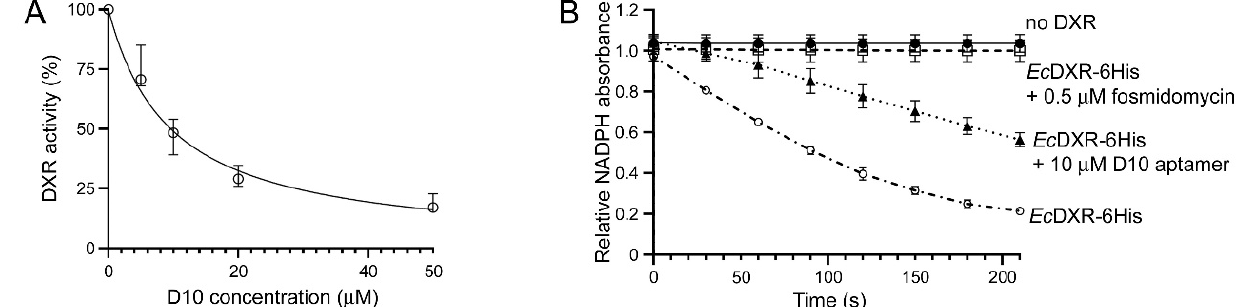
Figure 5. Ec DXR-6His in vitro activity assays. ( A ) DXR activity assays done at different D10 concentrations. ( B ) Positive (in the presence of DXR without inhibitor) and negative control activity assays (in the absence of DXR and in the presence of DXR with 0.5 µM fosmidomycin) compared to the test sample containing DXR and 10 µM D10.